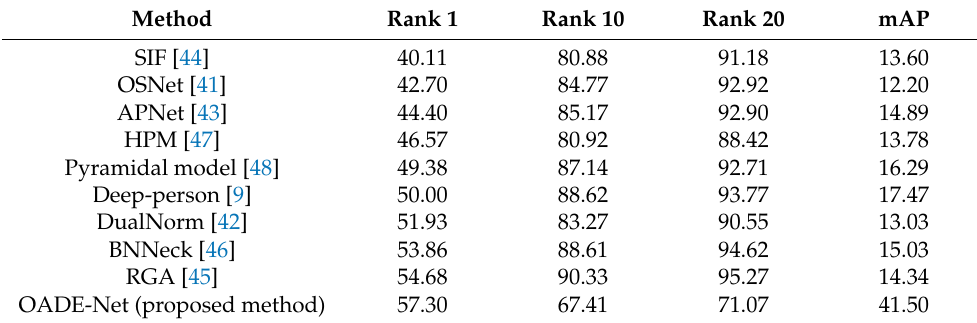
Table 10. Comparisons of the ReID accuracies by the proposed and state-of-the-art methods with SYSU-MM01 (unit: